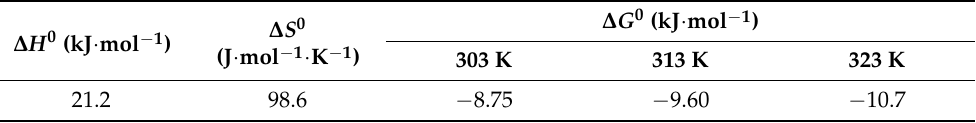
Table 5. Results of thermodynamic